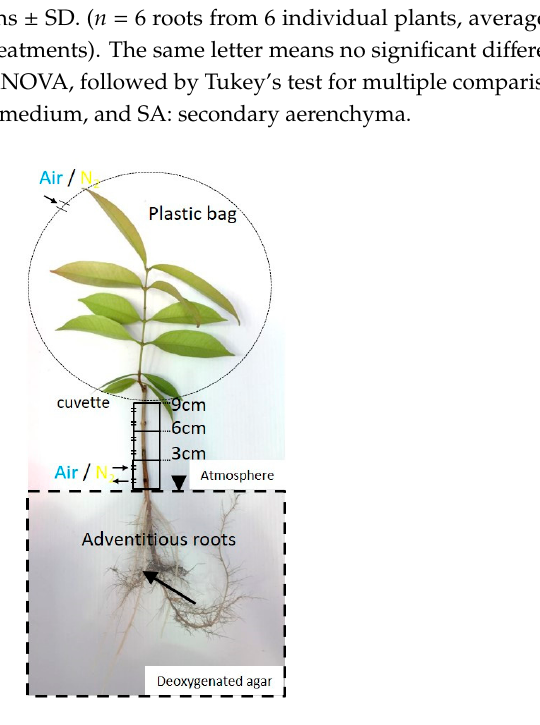
Figure 6. Entry portion of atmospheric oxygen into the stem of Syzygium kunstleri . Air or N 2 was injected through a 3-cm-cuvette and plastic bag to restrict oxygen from each part of the stem and leaf. The stem was divided into four parts: 0–3 cm, 3–6 cm, and 6–9 cm above the water level and the leaf. N 2 was injected for 30 min through the cuvette covering the stem and for 1 h through a plastic bag-sealed leaf(arrows). Arrow: measurement point; arrowhead: water level.